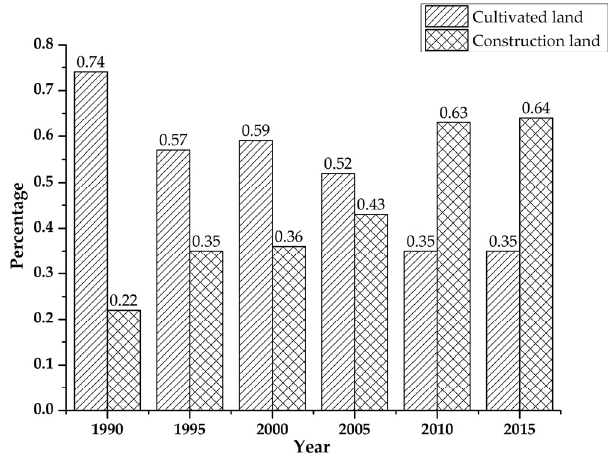
Figure 6. Comparison of cultivated and construction land in BCT regions from 1990 to 2015.